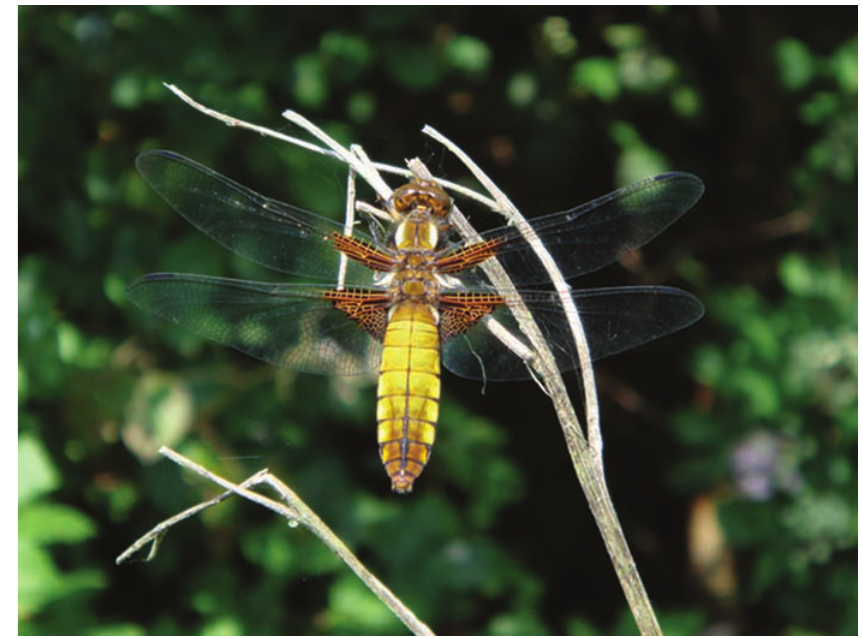
Figure 6 Bee orchids growing in the exposed gravel face in the northwest of Q1 Figure 7 A Broad-bodied Chaser at rest on the Quarry 1 southern boundary